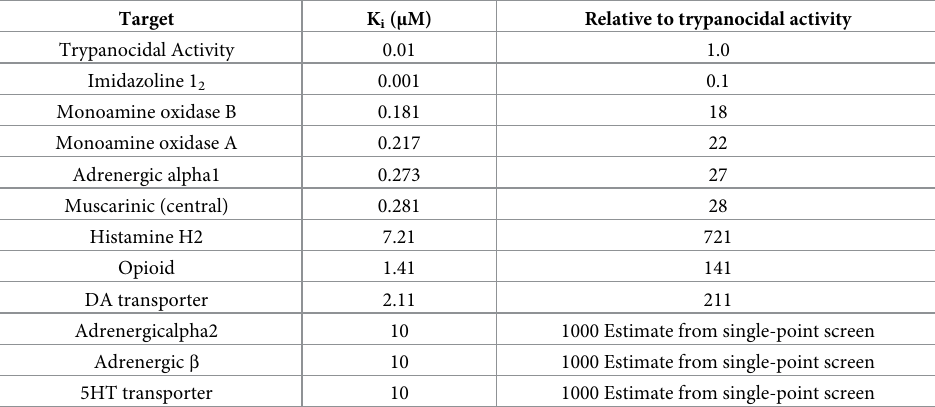
Table 3. K i Values for Pentamidine Determined for Selected CNS targets together with the relative selectivity value when the K i is compared to trypanocidal activity (IC 50 ).These results, together with the calculated relative selectivity values compared with trypanocidal affinity, are listed in Table